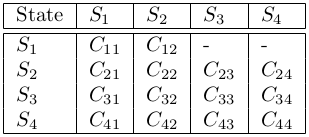
Table from the paper: Vision-based Engagement Detection in Virtual Reality
Table text:
State
S 1
S 2
S 3
S 4
S 1
C 11
C 12
-
-
S 2
C 21
C 22
C 23
C 24
S 3
C 31
C 32
C 33
C 34
S 4
C 41
C 42
C 43
C 444